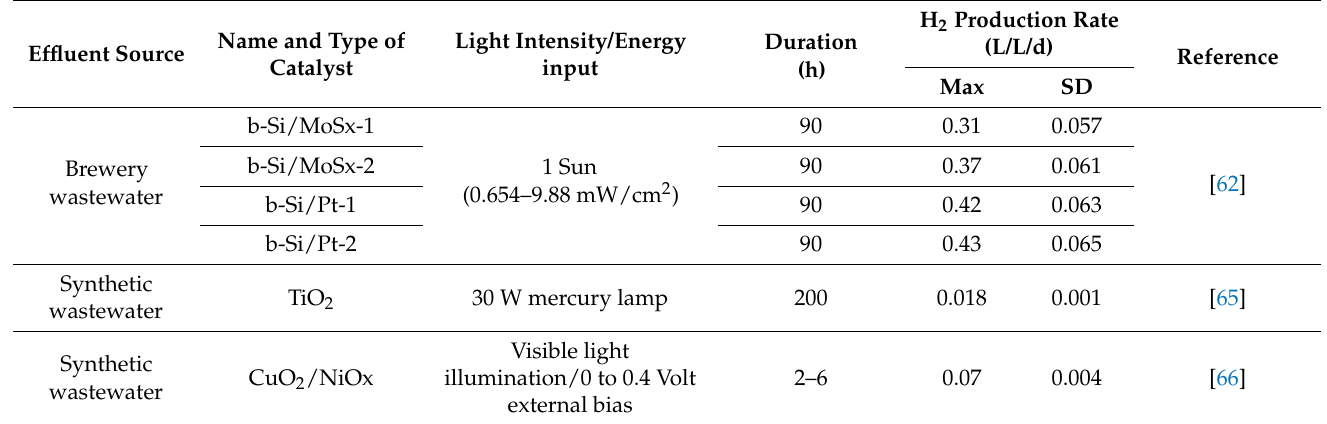
Figure 6. Schematic diagram of microbial photo electrochemical cell (MPEC). Table 6. Hydrogen production via MPEC.